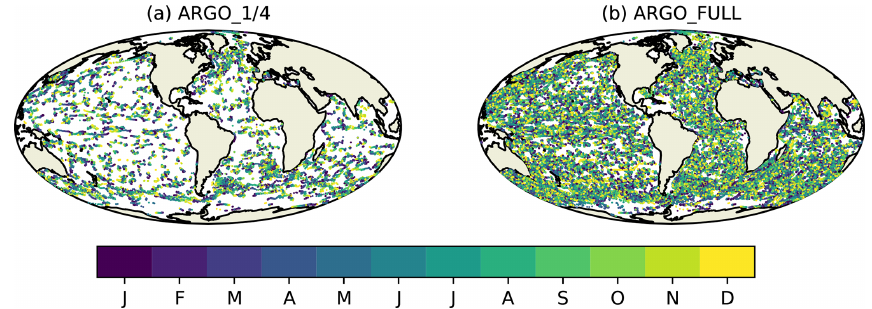
Figure 1. Simulated BGC-Argo float trajectories for 2009 equivalent to having biogeochemical sensors on (a) one in four Argo floats and (b) all Argo floats. Colours represent the month in which each observation is